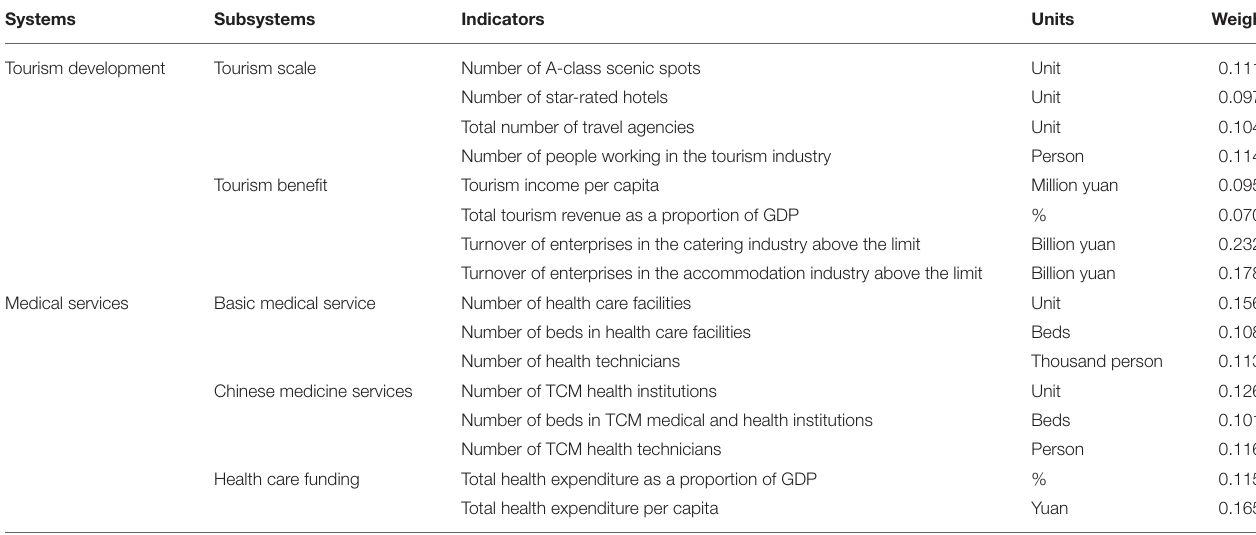
TABLE 1 | Coupling coordinated evaluation index system of tourism development and medical